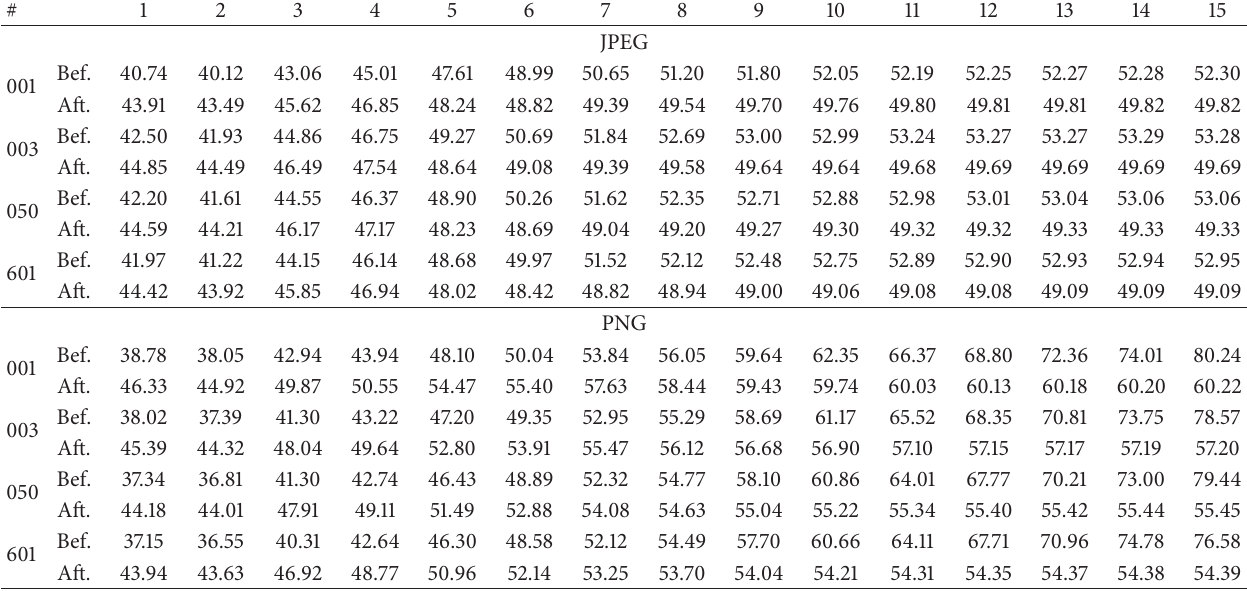
Table 10: PSNR result on Gaussian